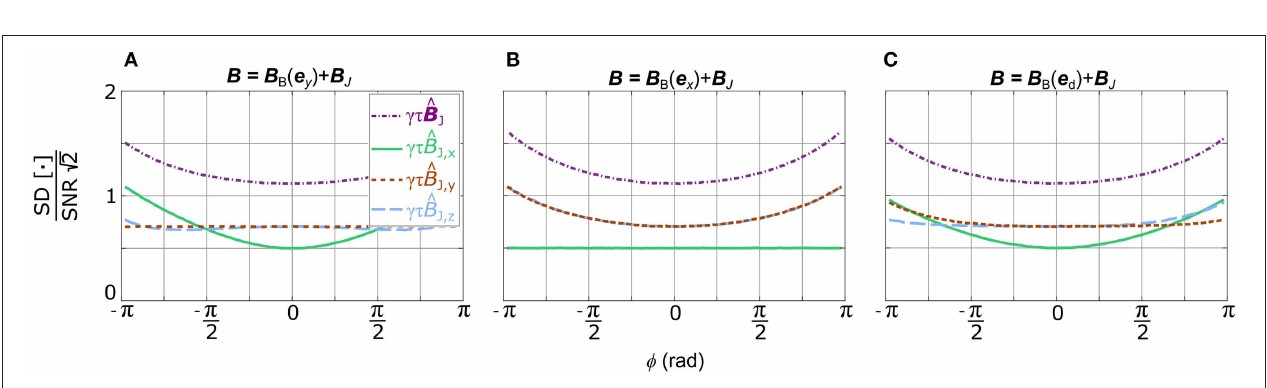
FIGURE 2 | Single-voxel Monte-Carlo simulations to estimate the influence of noise on three different steps of the non-linear reconstruction as a function of the rotation angle φ . The shown data are based on simulated noisy rotation matrices, where the first row was derived by the cross product of the other two. Displayed are normalized standard deviations of each component of ˆ B , which is the reconstruction of y -directional field B φ with the negative angles corresponding to the field direction without pre-referencing (A) , with pre-referencing (B) , and with subsequent orthogonalization using Löwdin’s transformation (C) .